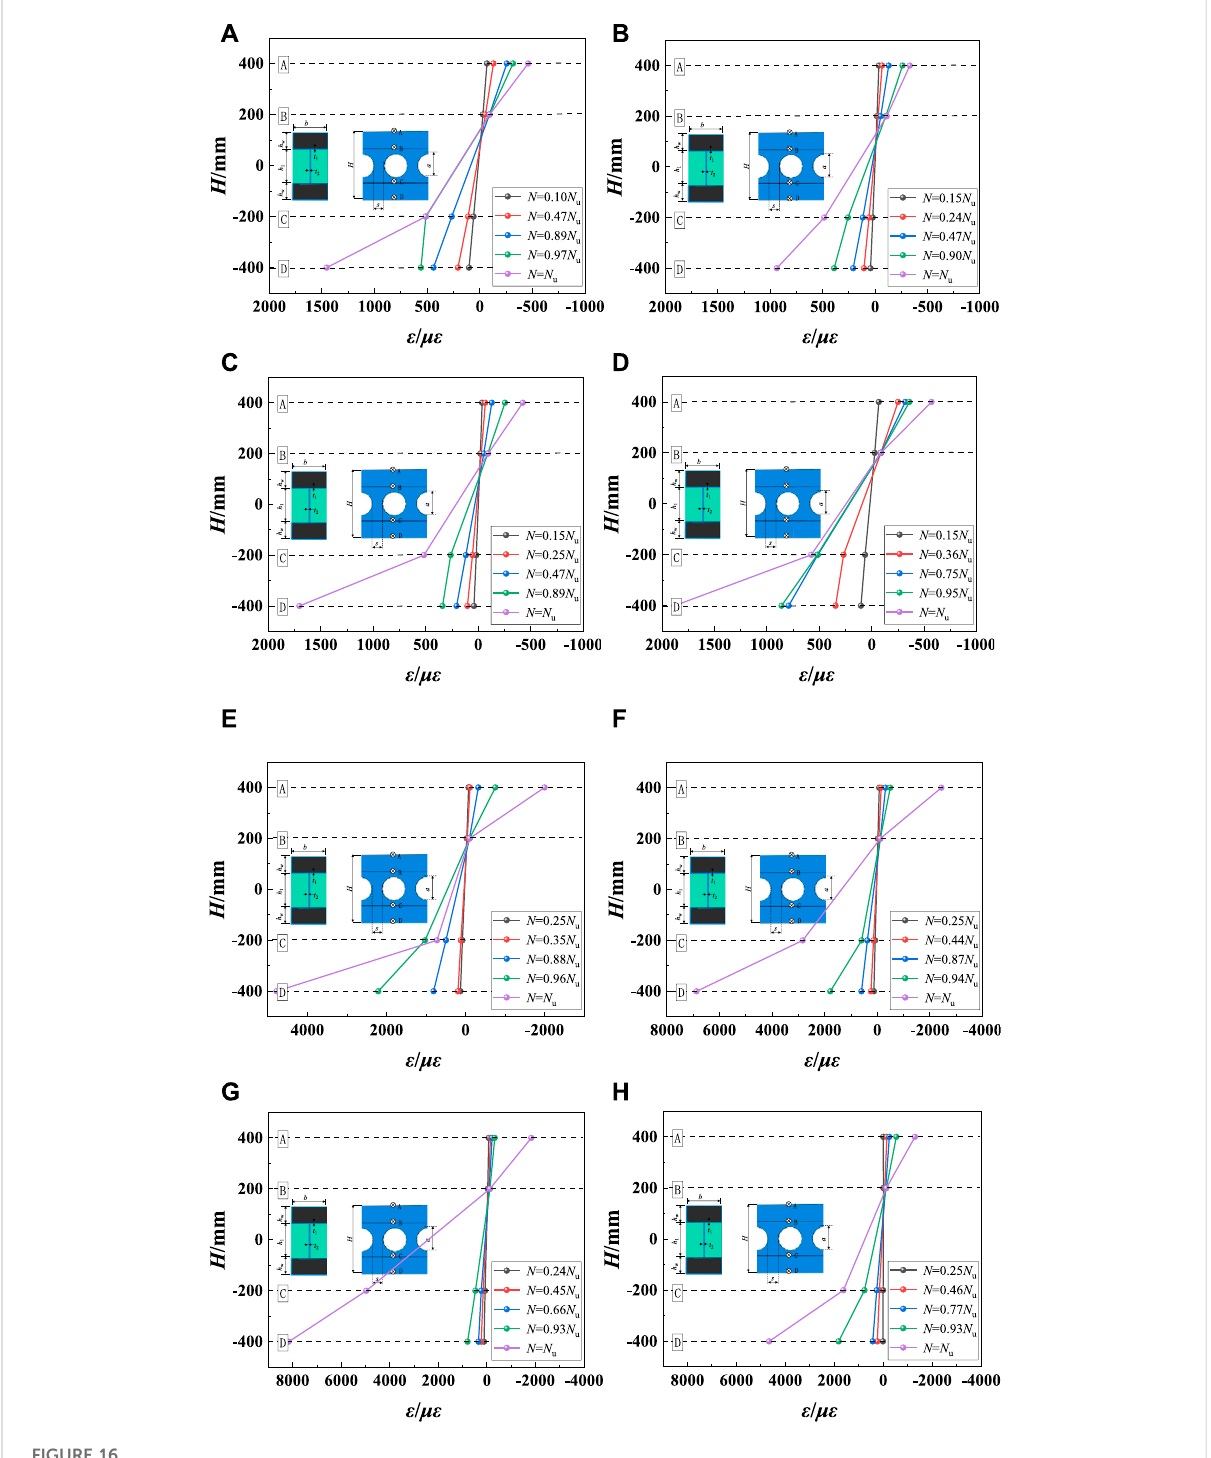
FIGURE 16 Longitudinal strain distribution along the height of mid-span section. (A) SHC1 (B) SHC2 (C) SHC3 (D) SHC4 (E) SHC11 (F) SHC12 (G) SHC17 (H)